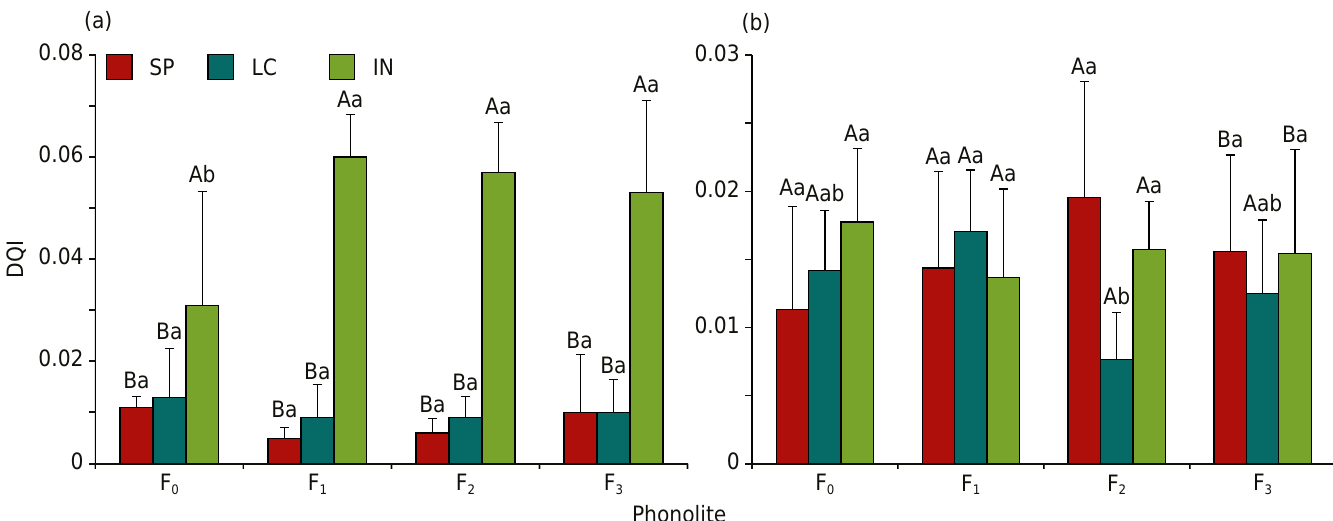
Figure 1. Dickson Quality Index (DQI) for seedlings of (a) Schinus terebinthifolius and (b) Eucalyptus saligna in mycorrhizal (SP, LC, and IN) and phonolite (F 0 , F 1 , F 2 , and F 3 ) treatments. F 0 : no phonolite, and addition of phonolite in particle sizes of 0.037 mm (F 1 ), 0.074 mm (F 2 ), and 0.149 mm (F 3 ). Uppercase letters compare means between mycorrhizal treatments, and lowercase letters compare means between phonolite treatments. Within each treatment, bars followed by the same letter are not statistically different according to the Tukey post hoc test